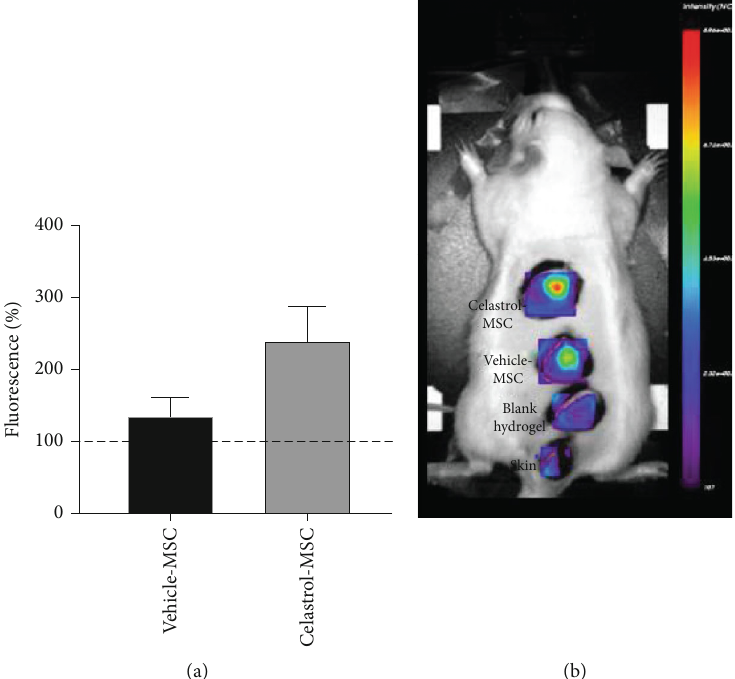
Figure 6: (a) Celastrol-treated hydrogel-encapsulated Vybrant-stained MSCs display 2.4-fold higher retention compared to vehicle-treated MSC at day 7 ( mean ± SEM , n = 8 , N = 2 ). (b) Representative fl uorescence imaging of Vybrant-stained encapsulated MSC at 7 days; blank: hydrogel alone containing no cells; skin: no hydrogel or